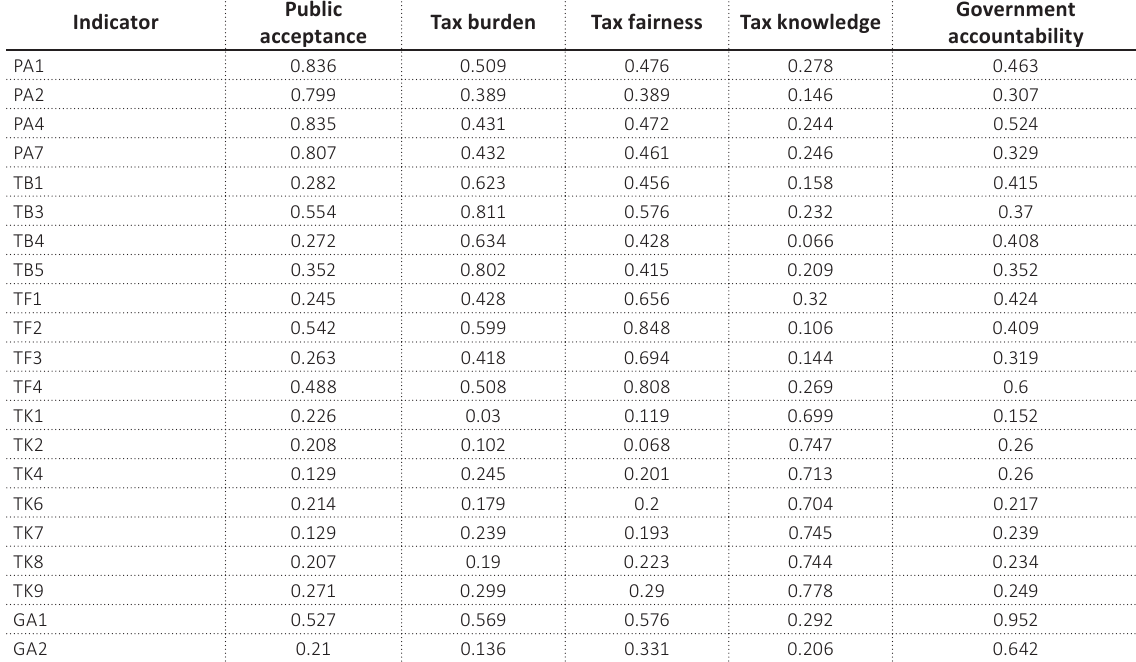
Table 3. Indicator cross-loadings analysis